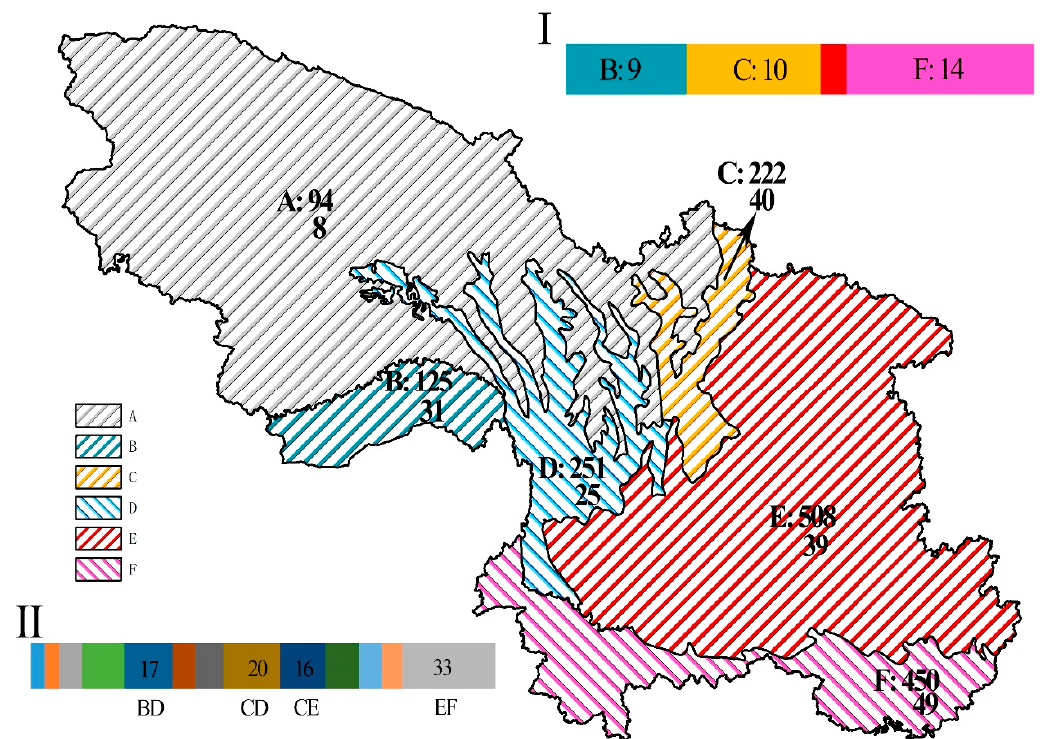
Figure 3. Division of research area. A: alpine shrublands and meadows; B: Eastern Himalayan broadleaf forests; C: Qionglai–Minshan conifer forests; D: Nujiang Langcang–Hengduan Mountains conifer and mixed forests; E: subtropical evergreen and mixed forests; F: tropical monsoon windy forest. Numbers next to each subregion refer to the number of species (top) and number of candidate species (bottom). ( I ) number of species that only indicate one subregion; ( II ) number of subregion combinations when species are indicative of multiple partitions.